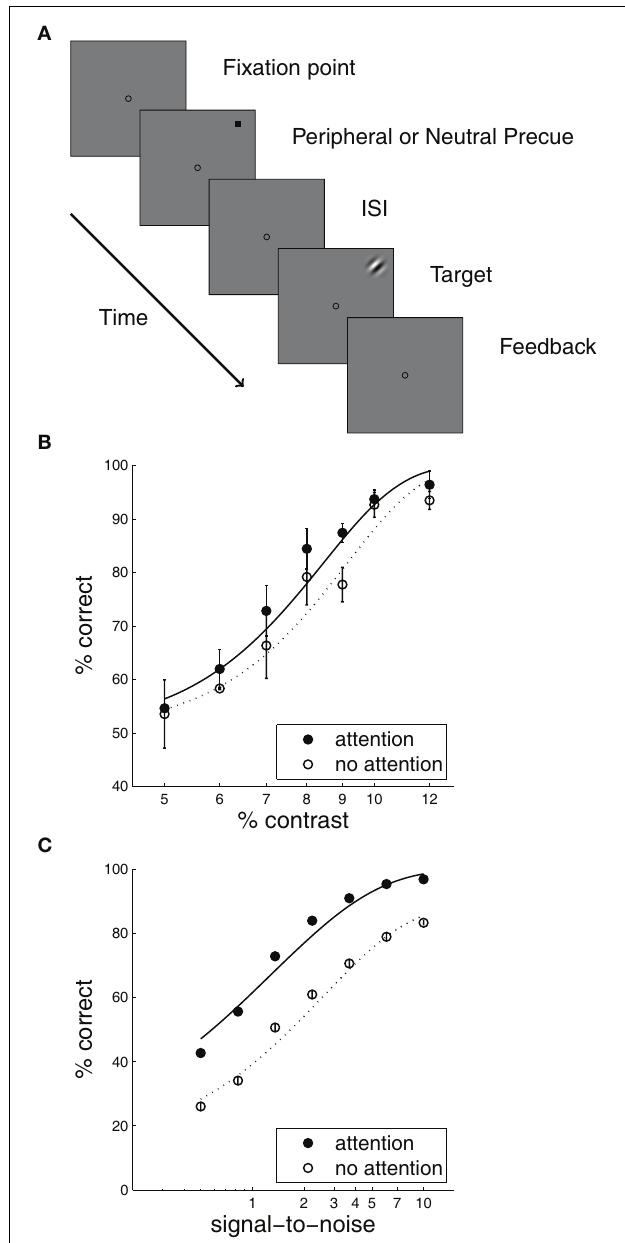
FIGURE 3 |The precueing task, with human and model results. (A) A schematic of a typical precueing task. Observers fixate the centre of the screen, and report whether a Gabor patch (“Target”) presented briefly at one of eight locations with 4.5˚ eccentricity is tilted to the left or right. Shortly before the patch appears a small transient black square is shown.This “precue” may either appear at fixation (Neutral, or “no attention”), or at the location of the upcoming target patch (Peripheral, or “attention”) (Adapted from Cameron et al., 2002). (B) Human observers’ mean performance with and without precue-directed attention, as a function of stimulus contrast. (Data from Cameron et al., 2002, 8 cycle per degree condition, averaged over three subjects and replotted. Error bars reflect inter-subject variation.) (C) Model performance with and without attention. Signal-to-noise in the sensory cue signal stands in for